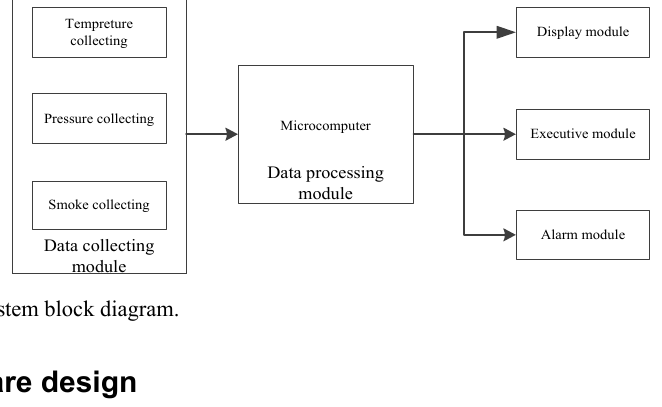
Fig. 1 . The system block